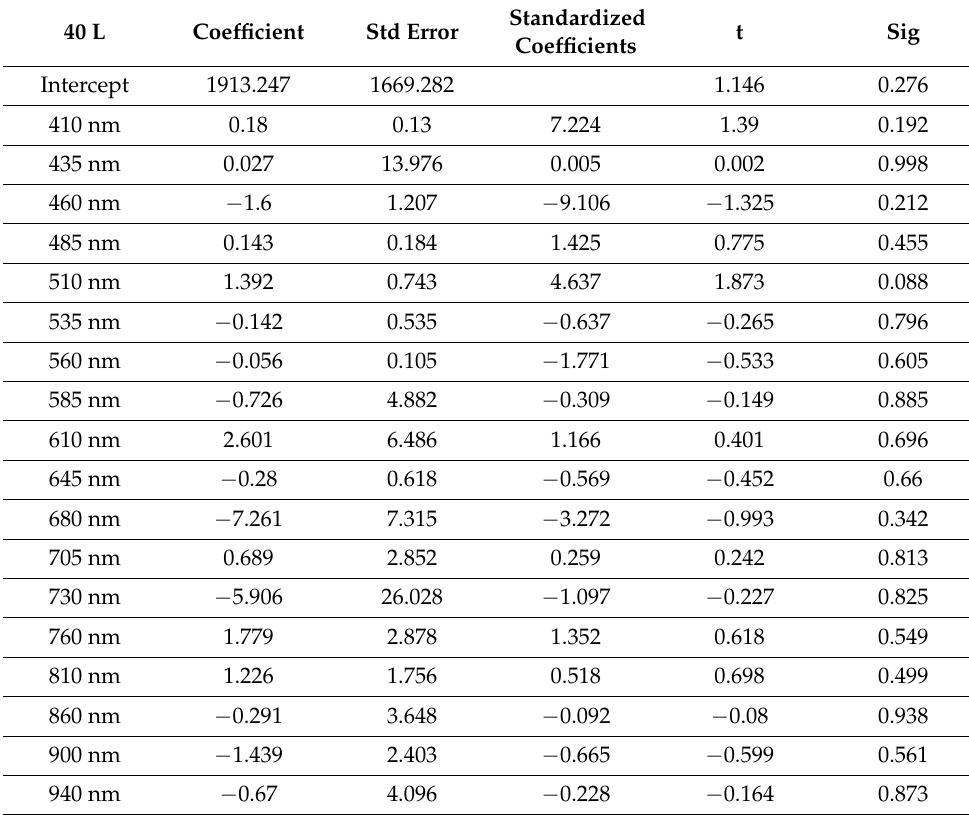
Figure 11. Tank S spectral absorbance rates over 28 days, plotted by wavelength. Table 8. Tank S MLR coefficients. All coefficients were included in the